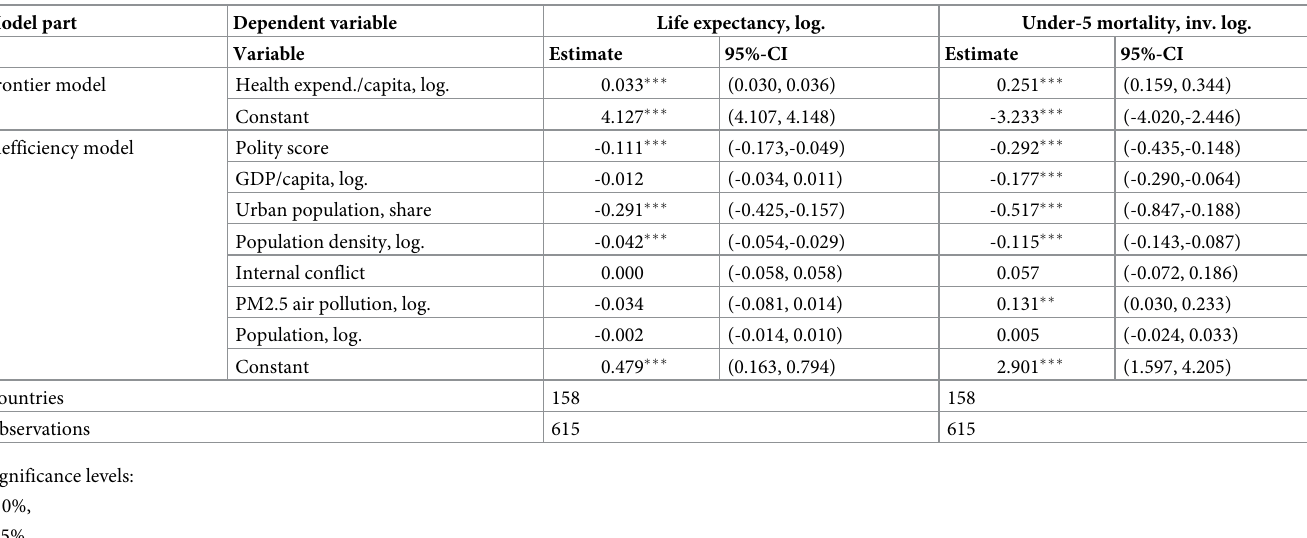
Table 3. SFA results for alternative population health